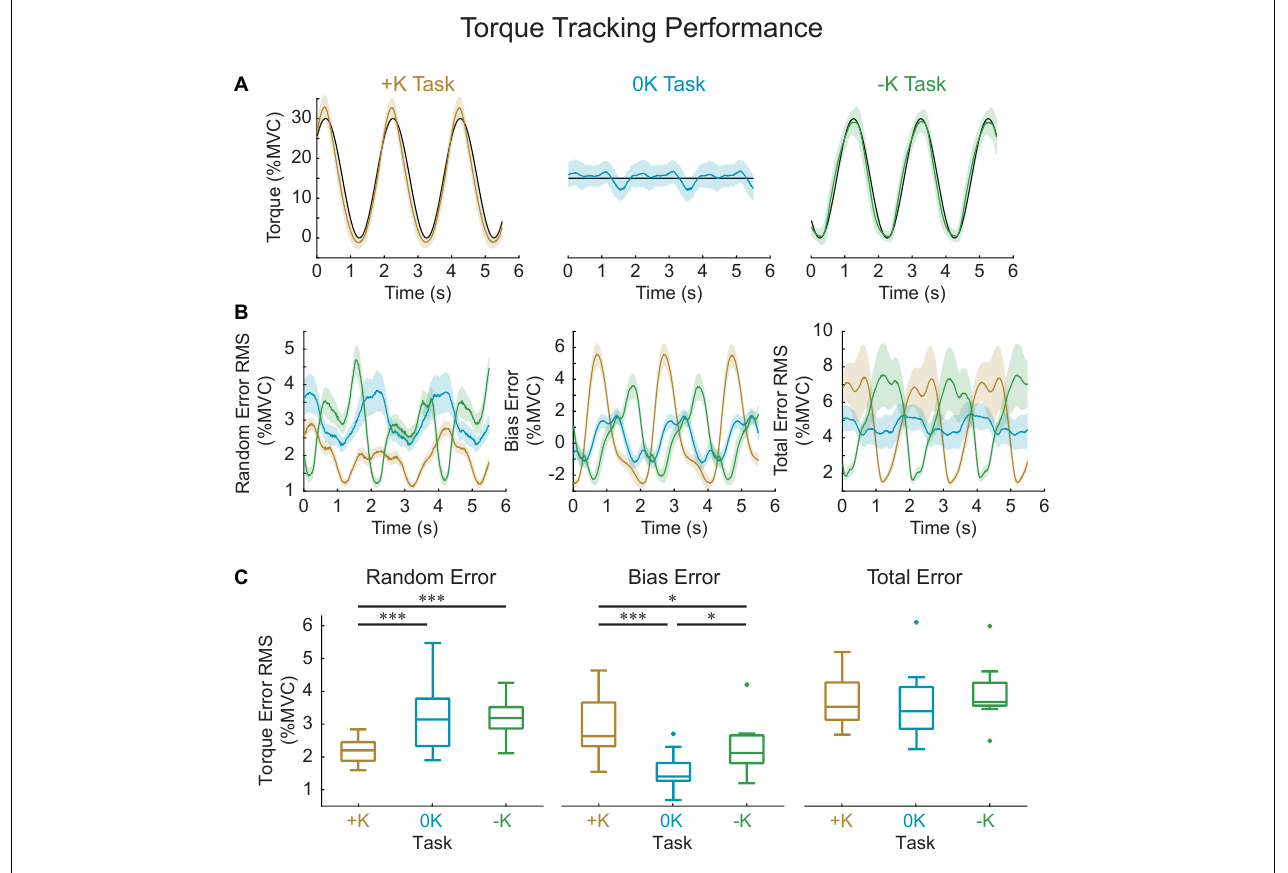
FIGURE 9 | Task performance was quantified by how well the measured torque matched the torque target in all three tasks. (A) Representative data for one subject, showing the target (black), the average measured torque (colored lines) and standard deviation across all the cycles of the movement (shaded area). (B) Computed random, bias and total error and their variation throughout the imposed movement. Solid shows group average, shaded area shows 95% confidence interval of the group average. (C) While the total error did not differ between the three tasks, the +K task did show less random error, indicating a more consistent task behavior when subjects could rely more heavily on impedance. * p < 0.05; *** p < 0.001.